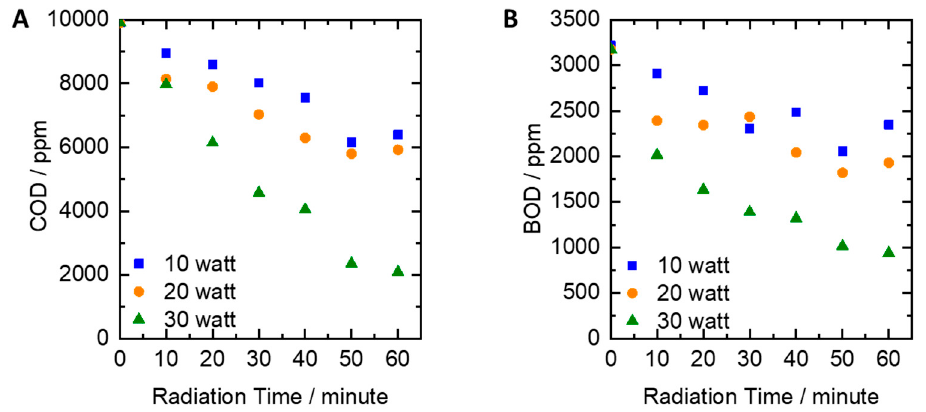
Figure 1. ( A ) Chemical oxygen demand (COD) and ( B ) biological oxygen demand (BOD) degradations of textile wastewater as functions of UV lamp power and irradiation time.